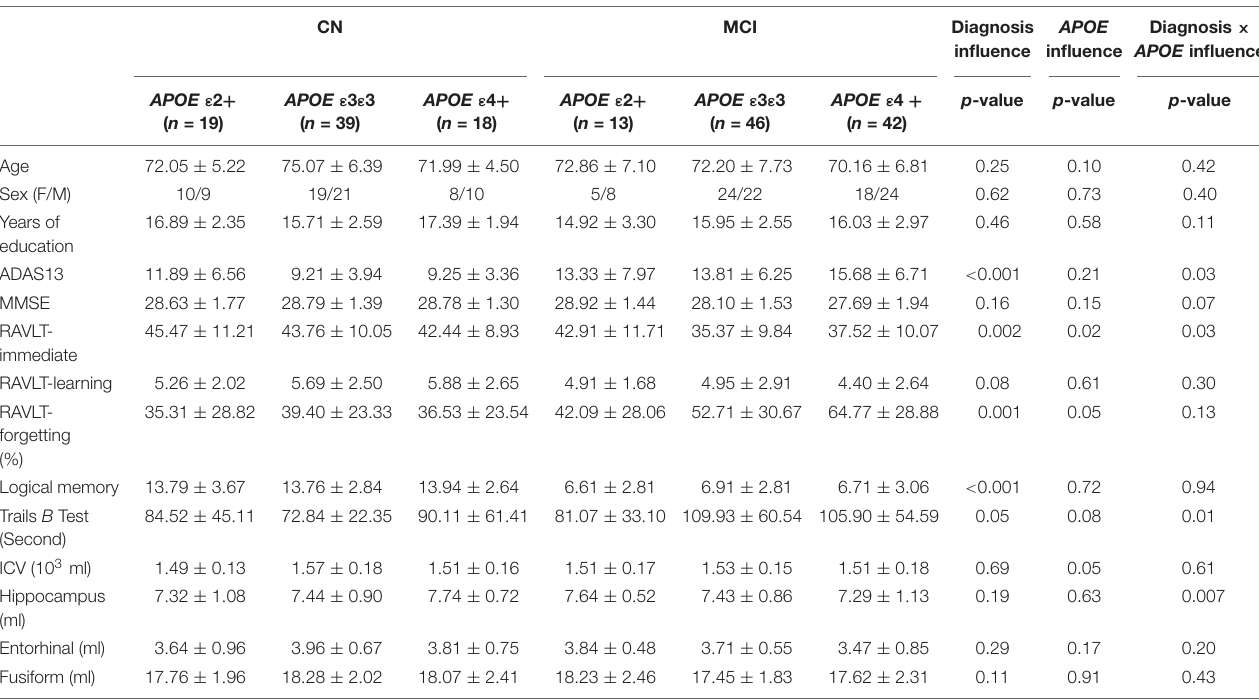
TABLE 1 | Demographic, neuropsychological, and brain structural information in each group. CN